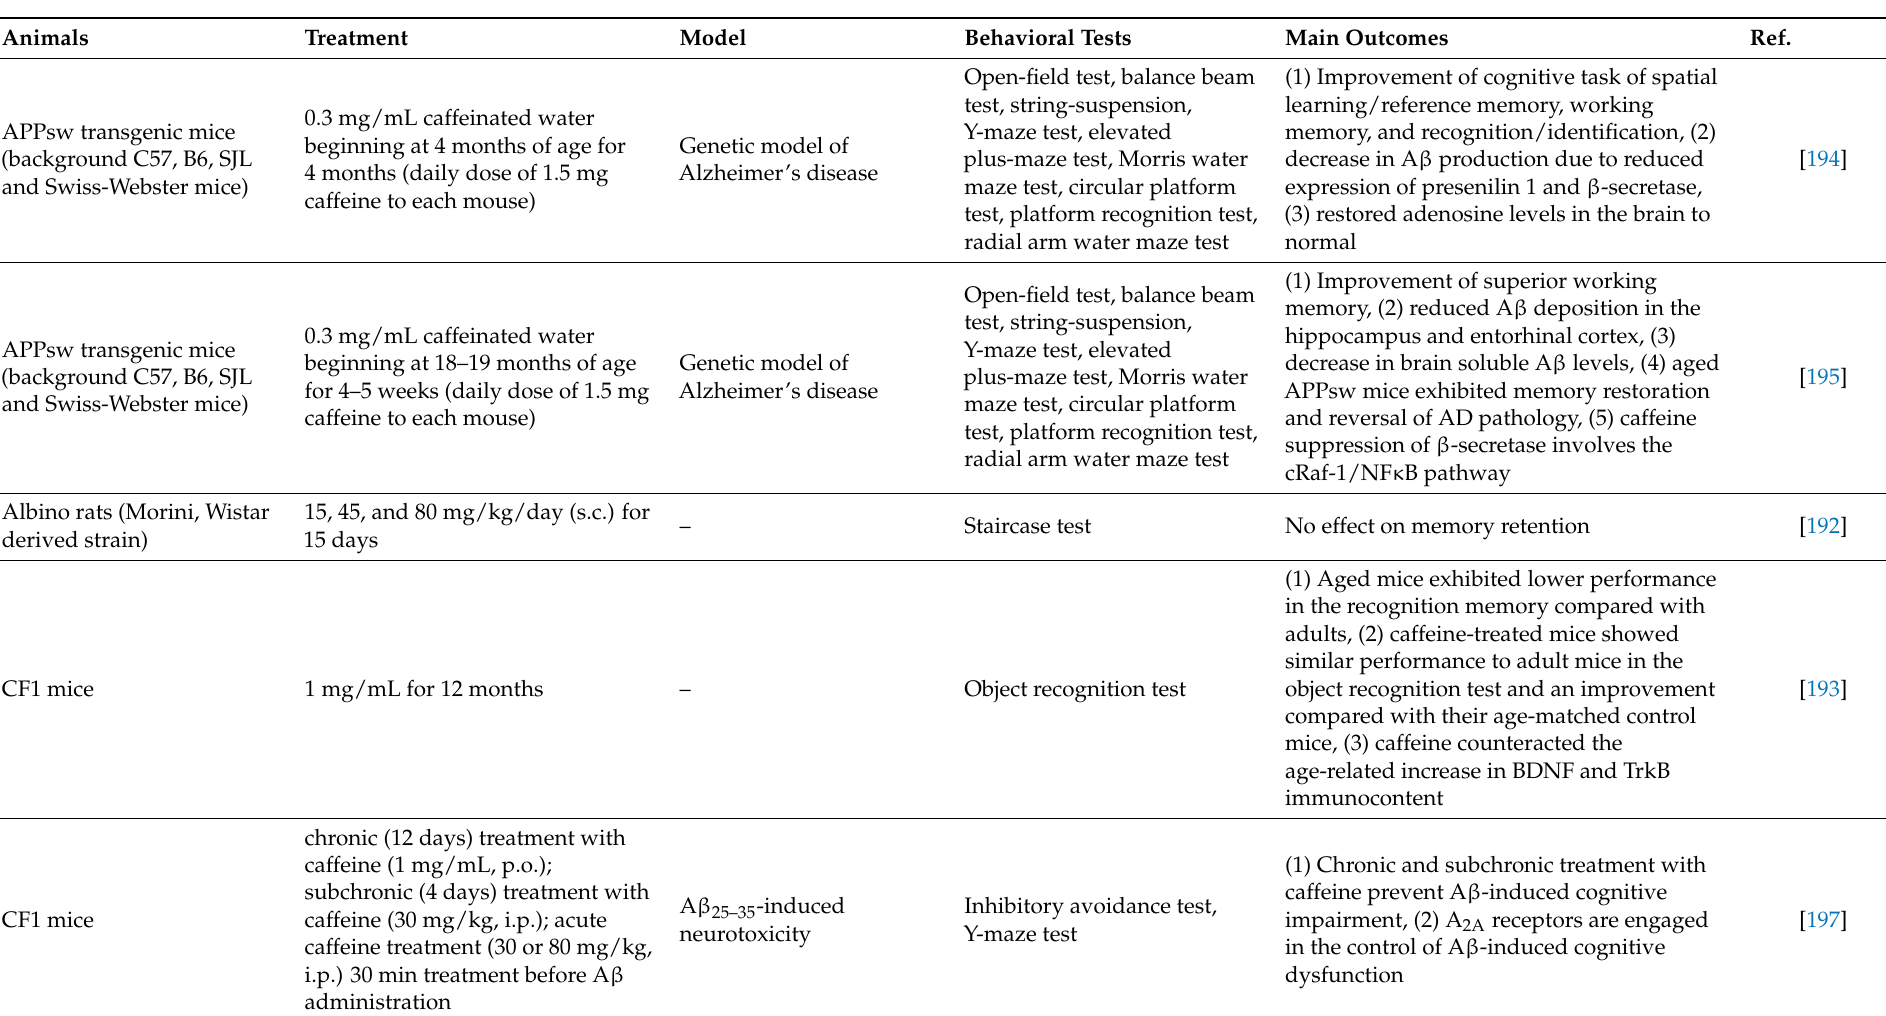
Table 3. Summary of in vivo studies on the neuroprotective effects of